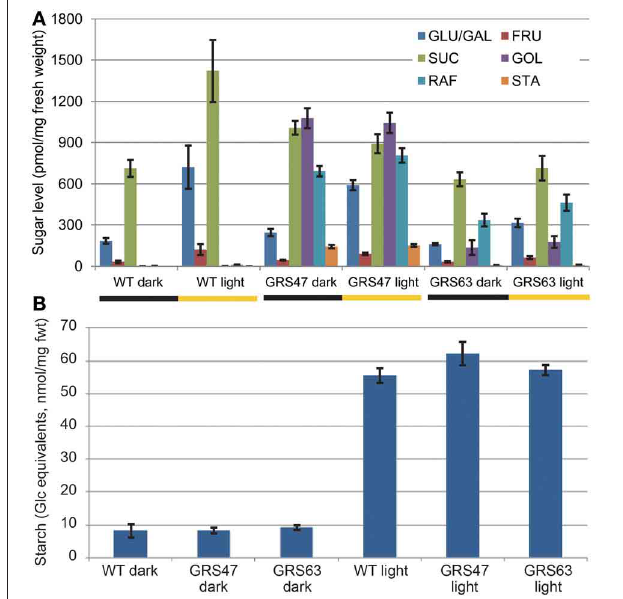
FIGURE 1 | Comparison of carbohydrate levels after 10h of dark and 8h into the 14h illuminated period. (A) Soluble neutral sugars as indicated (pmol sugar/mg fresh weight) (note: separation conditions were optimized for Gol, Raf, and Sta, and Glc and Gal elute together. In elutions that do separate Glc and Gal, Gal levels were always negligible). (B) Starch levels from the same samples as (A) , expressed as Glc equivalents. Variation is expressed as SE; n = 6 sibling plants. Student’s t -Test analysis was also conducted to assess differences ( p < 0 . 05) in the level of each sugar within each line between 10h of dark and 8h of illumination. Glc, Fru, and starch were significantly increased in all lines, Suc increased significantly only